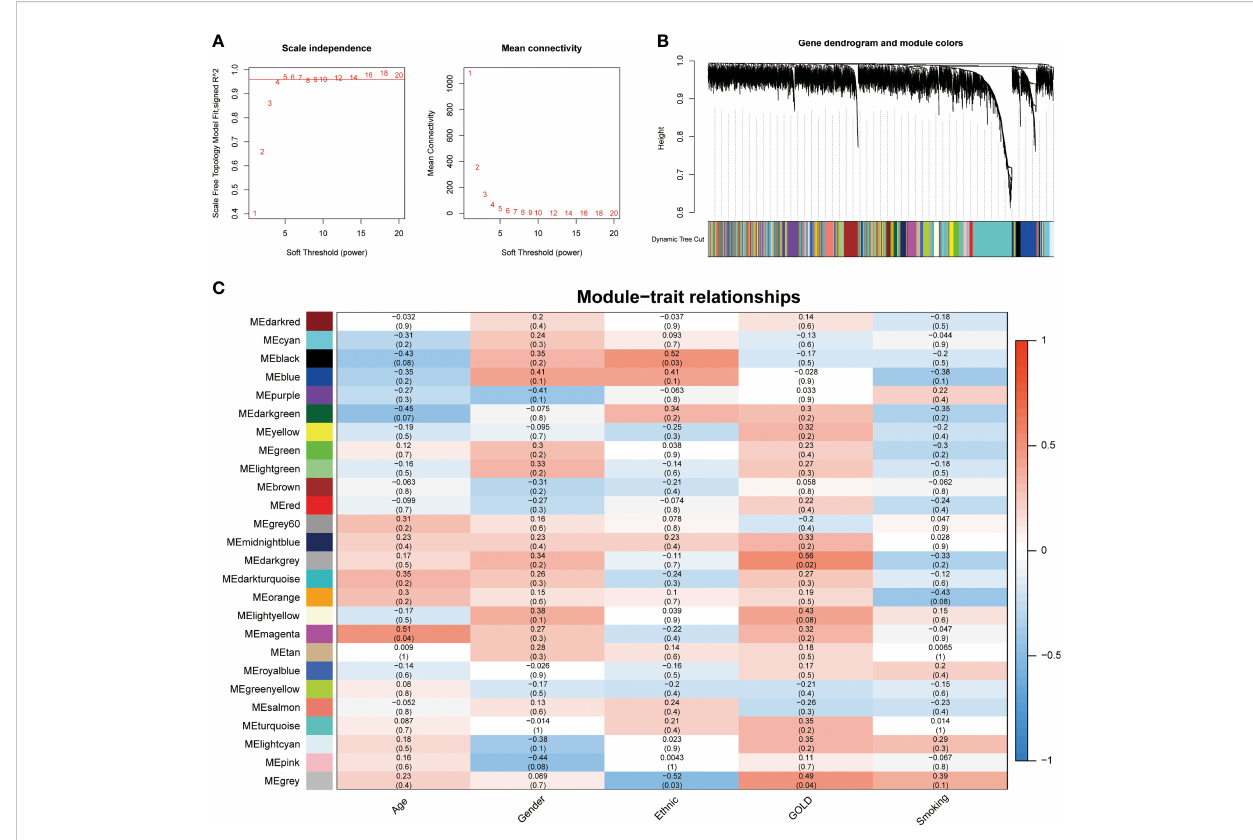
FIGURE 4 Identi fi cation of crucial modules correlating to the GOLD stage via WGCNA. (A) Scale-free fi t index and the mean connectivity of different soft threshold powers. (B) Dendrogram of differentially expressed genes clustered according to distinct metrics. (C) Heatmap illustrating the relationship between module eigengenes and clinical traits (age, gender, ethnic, GOLD, and smoking). Each cell displayed the respective correlation coef fi cient and P